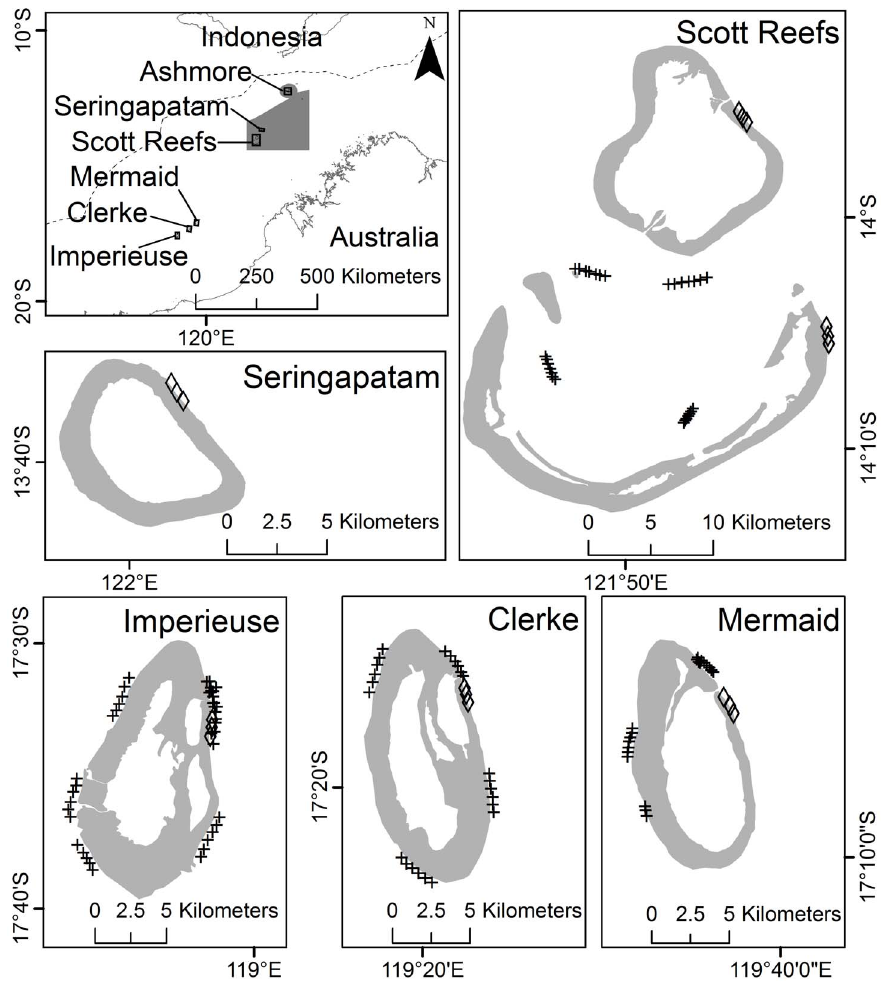
Figure 1. The protected Rowley Shoals (Imperieuse, Clerke and Mermaid Reefs) and fished Scott Reefs (Seringapatam, North Scott and South Scott Reefs). Locations of baited remote underwater video stations (crosses) and long term monitoring program sites (diamonds) are shown on each reef (light grey). The dotted line shows the Australian Economic Exclusive Zone boundary and dark grey denotes the MoU Box 74.